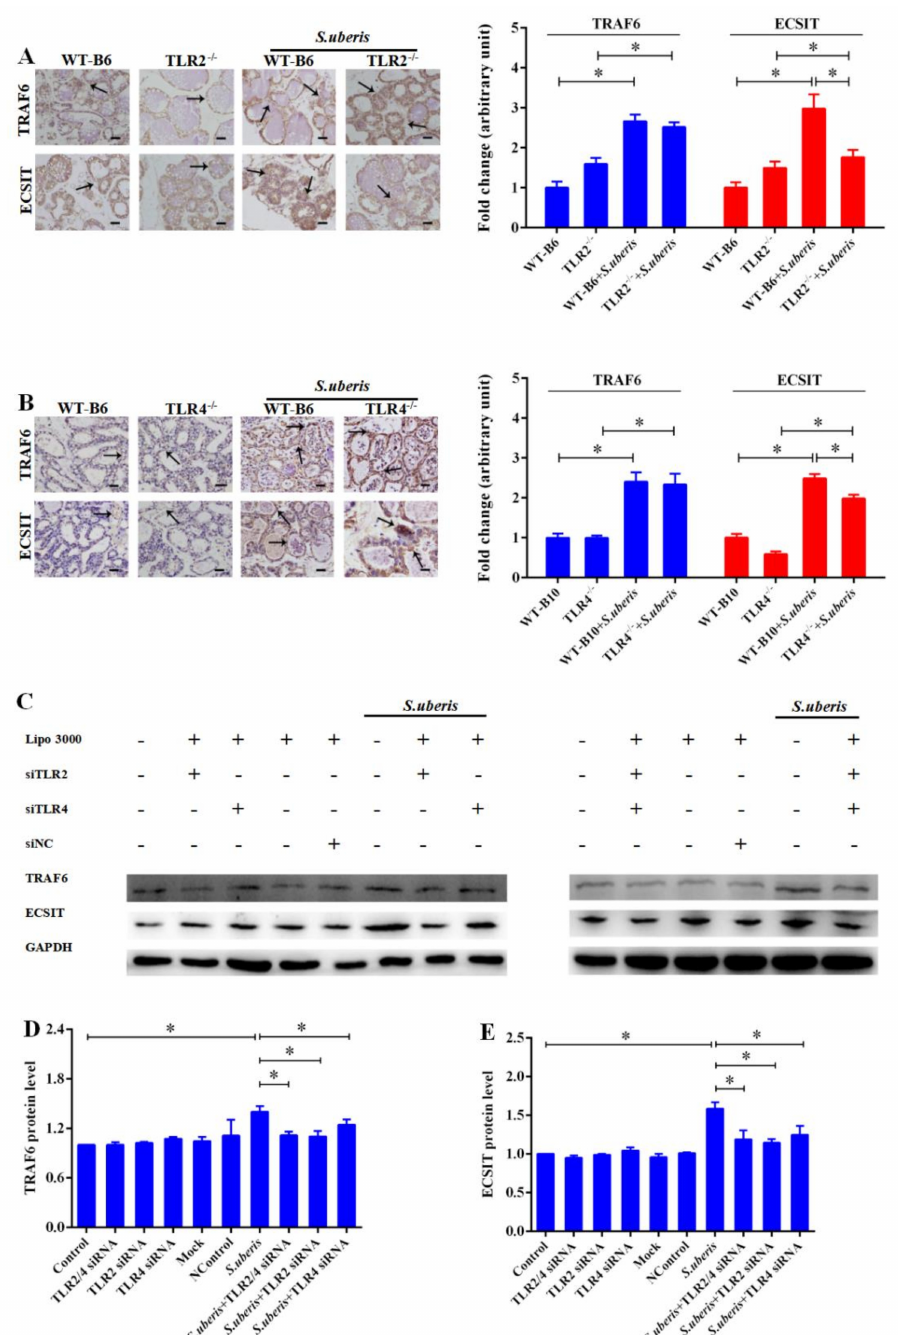
Figure 4. TRAF6 and ECSIT participate in sensing signal from Toll-like receptors (TLRs) in S. uberis infection. ( A ) Immunohistochemistry was used to analyze the protein expression levels of TRAF6 and ECSIT in mammary gland of WTB6 and TLR2 − / − mice with or without S. uberis . ( B ) Immunohistochemistry was used to analyze the protein expression levels of TRAF6 and ECSIT in mammary gland of WTB10 and TLR4 − / − mice with or without S. uberis . Images are representative of n = 6 animals per genotype. Scale bars, 100 µ m. Data were presented as the means ± SEM ( n = 6). * ( p < 0.05) = significantly di ff erent between the indicated groups. ( C , D , E ) The protein expression levels of TRAF6 and ECSIT of WTB6, WTB10, TLR2 − / − , TLR4 − / − mice with or without S. uberis were determined by Western blot in MECs. For quantitative analysis, bands were evaluated densitometrically with Image J analyzer software normalized for GAPDH density. Experiments were repeated three times and data were presented as the means ± SEM ( n = 3). * ( p < 0.05) = significantly di ff erent between the indicated